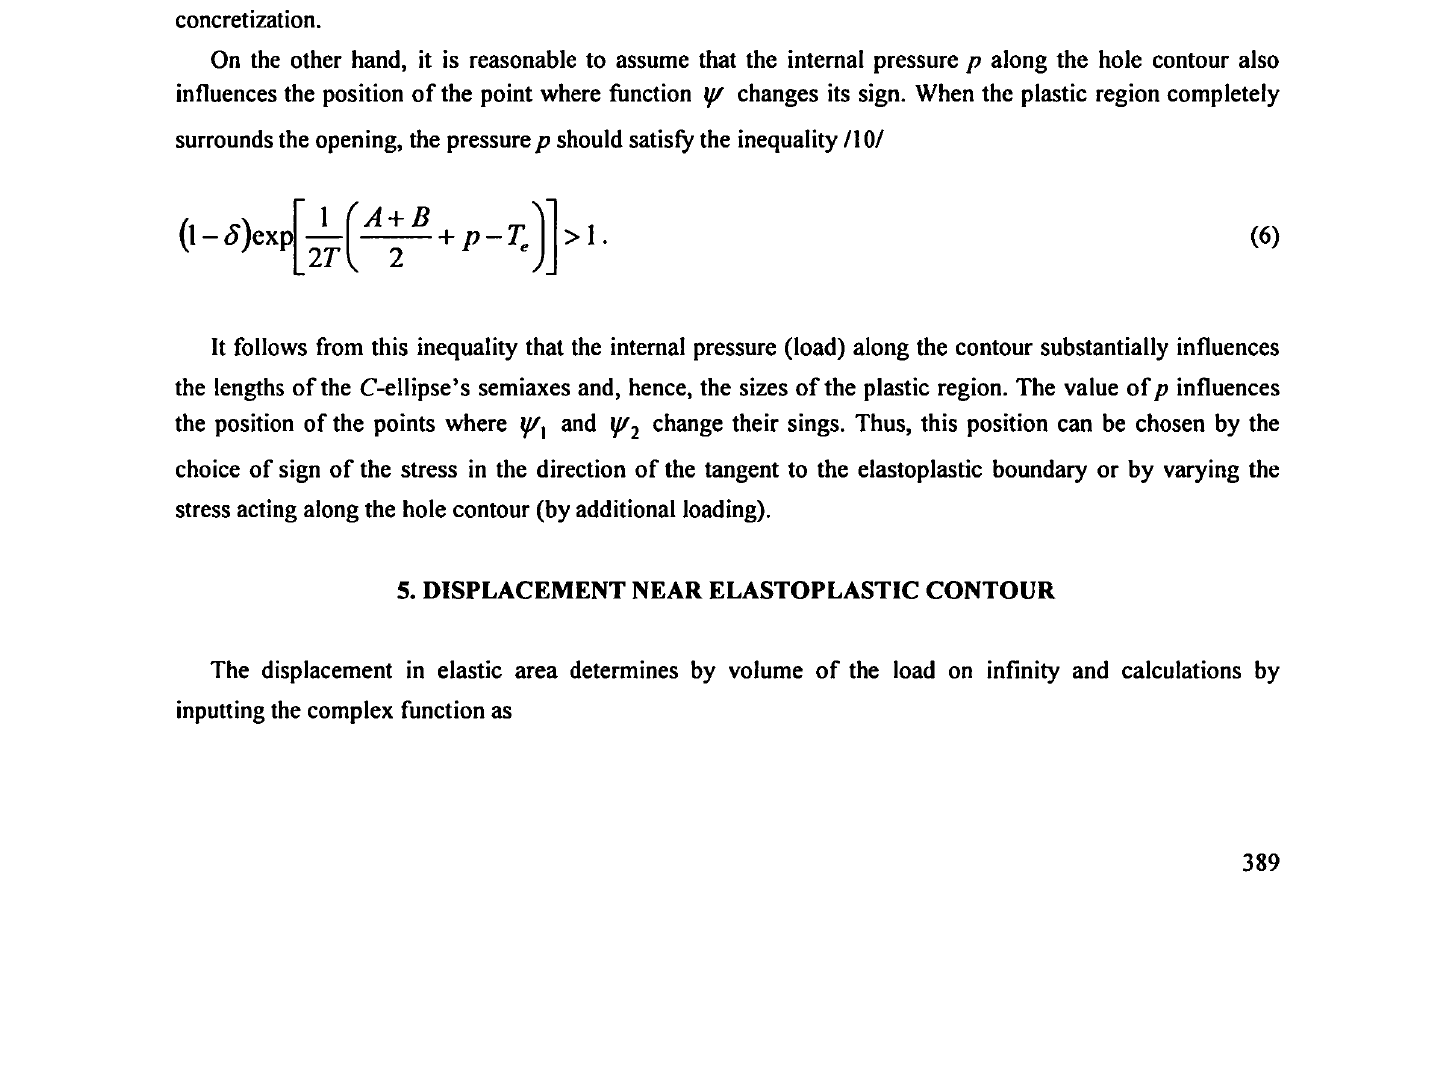
Fig. 3: The angle of inclination of the strain-tensor principal